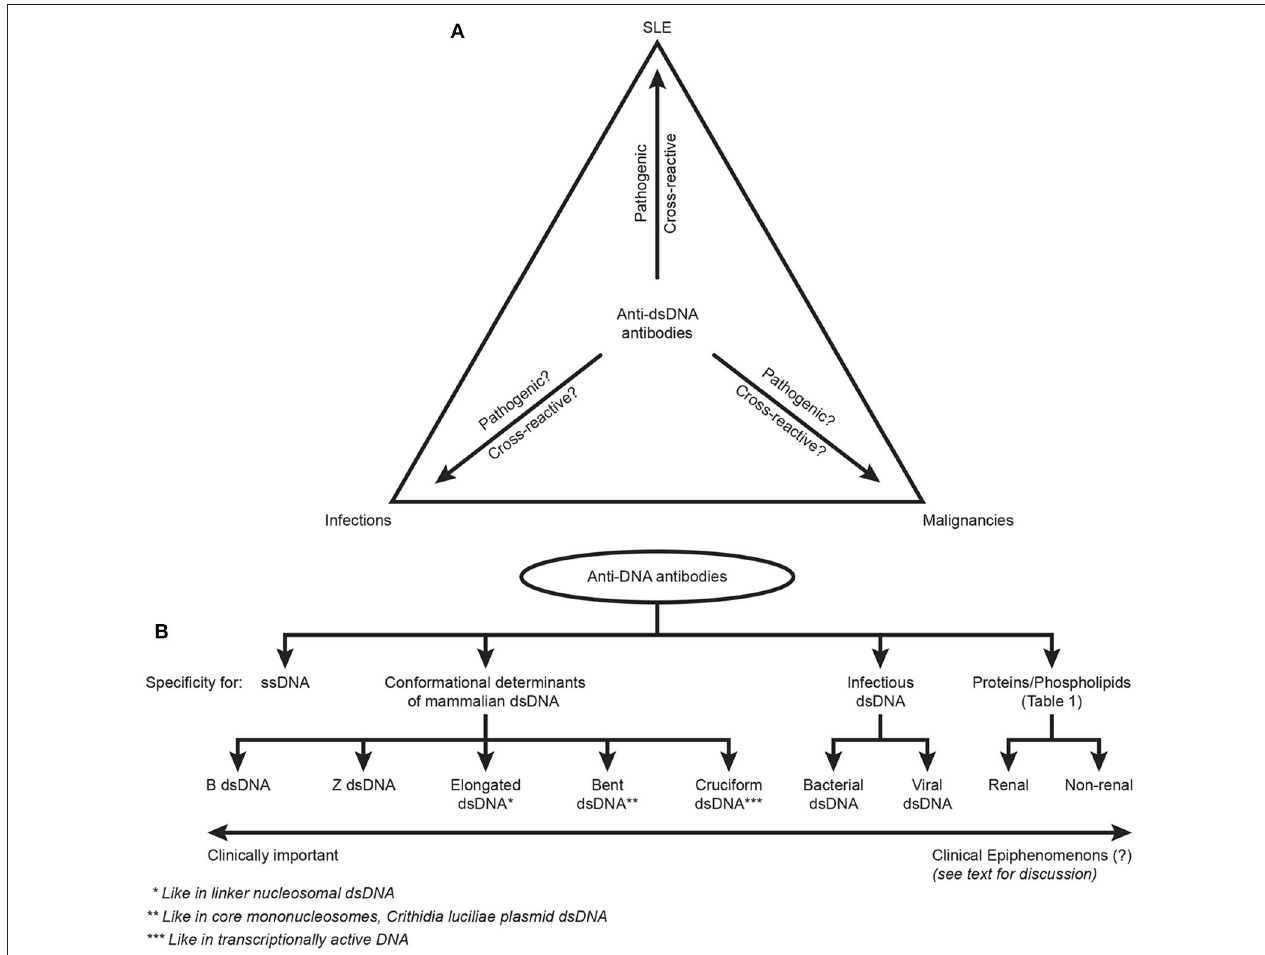
FIGURE 2 | Principal problems linked to the ACR and SLICC classification criterion “The anti-dsDNA antibody” (criterion 11 in ACR) or “Anti-dsDNA” (criterion 6, Immunological criteria, SLICC). Principal simplified problems are linked to the inadequate terminology of the anti-dsDNA antibodies. One problem [demonstrated in (A) ] illustrates that “The anti-dsDNA antibody” is not unique for SLE, but appears regularly in context of infections and malignancies (see text for details). Little is examined whether anti-dsDNA antibodies are pathogenic and cross-reactive in the latter two categories of conditions (question marks in A ) as they are in SLE. This triangular nature of anti-dsDNA antibodies has not been considered in the classification criteria, and poorly in the relevant literature on SLE. The second dominant problem considered for the “Anti-dsDNA antibody” is that the antibodies are presented as if “it” is monospecific for dsDNA. This has over decades crystallized the conception that different assay systems detect antibodies possessing different avidities but not different specificities ! This conflict is principally demonstrated in (B) . The “ssDNA/dsDNA” is categorized in 4 main categories with 5 subcategories for mammalian dsDNA, 2 for infectious dsDNA and 2 for cross-reaction of anti-dsDNA for renal and non-renal proteins/phospholipids (see Table 1 for details on the latter category). Antibodies for all these dsDNA structures have been identified by conventional assay systems, like ELISA in physiological salt (elongated/bent B dsDNA), in high salt (Z dsDNA), cruziform dsDNA, bacterial and viral dsDNA in addition to heterogeneous binding to proteins and phospholipids. The idiom that anti-dsDNA antibodies bind dsDNA in a singular form as in the ACR or SLICC classification systems must be challenged by the multifaceted recognition pattern of anti-dsDNA antibodies as informed in (B) . Thus, data in this figure require that assay systems for anti-dsDNA antibodies relates to categorized structural dsDNA specificities. Lack of implementation of the structural and molecular recognition pattern recognized by individual anti-dsDNA antibodies undermine the potential clinical impact of anti-dsDNA antibody